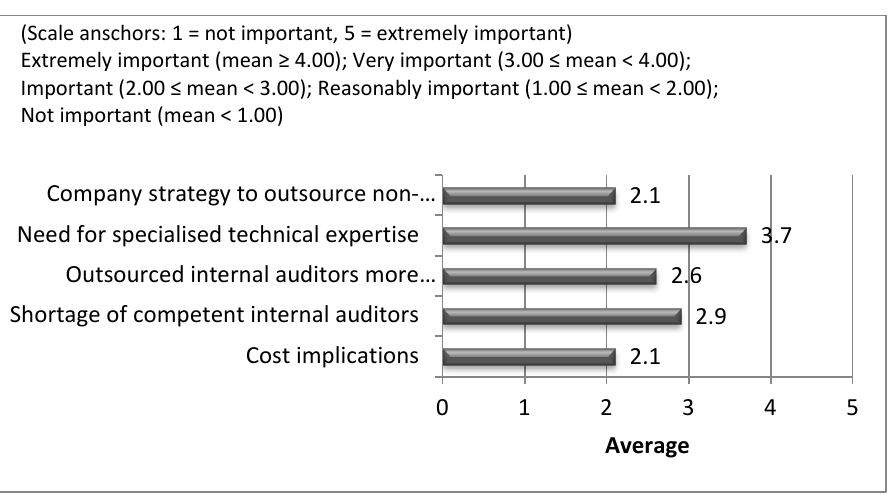
FIGURE 1: Reasons for the decision to outsource the internal auditing function Source: IIASA